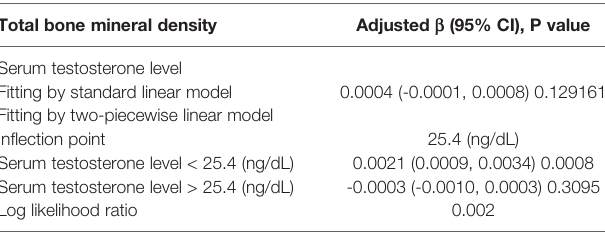
TABLE 5 | Threshold effect analysis of serum testosterone level on total bone mineral density using two-piecewise linear regression